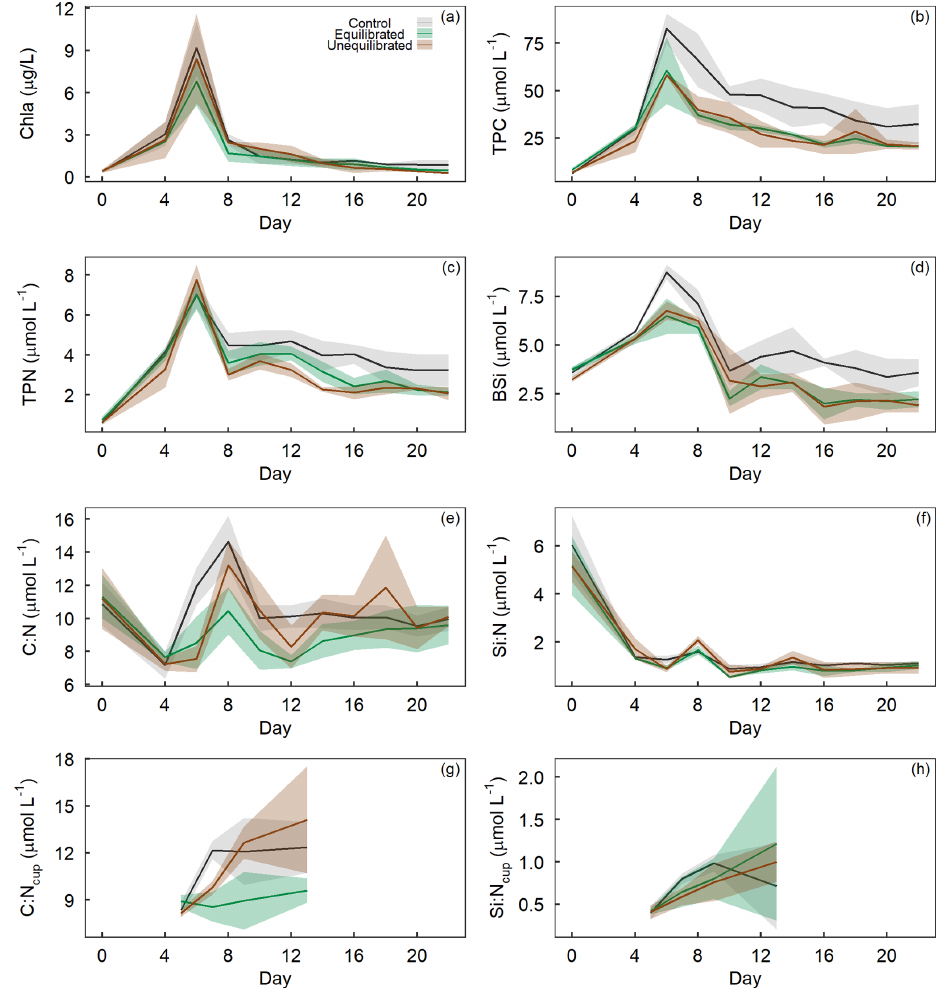
Figure 5. Temporal trends of (a) chlorophyll a , (b) total particulate carbon, (c) total particulate nitrogen, and (d) biogenic silica concentra- tions, as well as molar ratios of (e) TPC to TPN and (f) BSi to TPN within microcosms and molar ratios of (g) TPC to TPN and (h) BSi to TPN within sediment collection cups, denoted by “C:N cup ” or “SI:N cup ”. Coloured shading around the respective means represents the standard